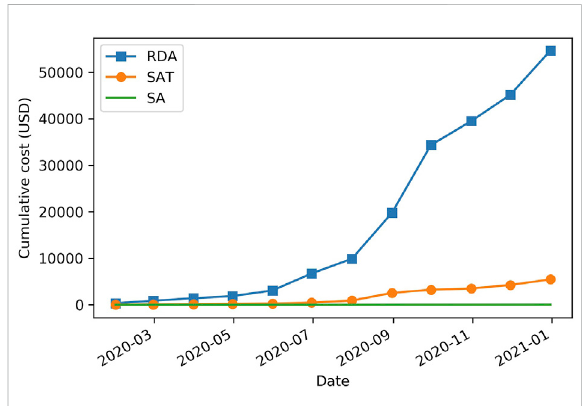
FIGURE 3 Cumulative cost comparison between the different blockchain data storing approaches: RDA (blue line with squares), SAT (orange line with circles), and SA (green solid